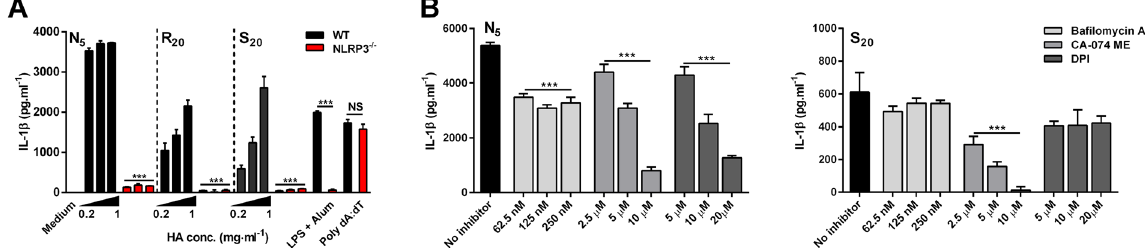
Figure 4. Hydroxyapatite particle-induced IL-1 β production is NLRP3 dependent. ( A ) BMDCs (0.625 × 10 6 cells · ml − 1 ) from C57BL/6 or NLRP3 − / − mice were stimulated with HA particles at concentrations ranging from 0.2 mg · ml − 1 to 1 mg · ml − 1 after priming with LPS (1 ng · ml − 1 ) for 3 h. Supernatants were collected after 24 hours and IL-1 β levels were measured by ELISA. Data are shown as mean ± SD for triplicate samples (vs WT *** p < 0.001; NS: non-significant). Results are representative of three independent experiments. ( B ) BMDCs (0.625 × 10 6 cells · ml − 1 ) from female C57BL/6 mice were primed with LPS (1 ng · ml − 1 ) for 3 h before stimulating with 0.8 mg · ml − 1 of HA particles; cells were incubated with the lysosome acidification inhibitor bafilomycin A (62.5–250 nM), the cathepsin B inhibitor CA-074-Me (2.5–10 µ M) and with the ROS inhibitor DPI (5–20 µ M) 1 h before particulate addition. Supernatants were collected after 24 hours and IL-1 β levels were measured by ELISA. Data are shown as mean ± SD for triplicate samples. Results are representative of three independent experiments (vs no inhibitor *** p <